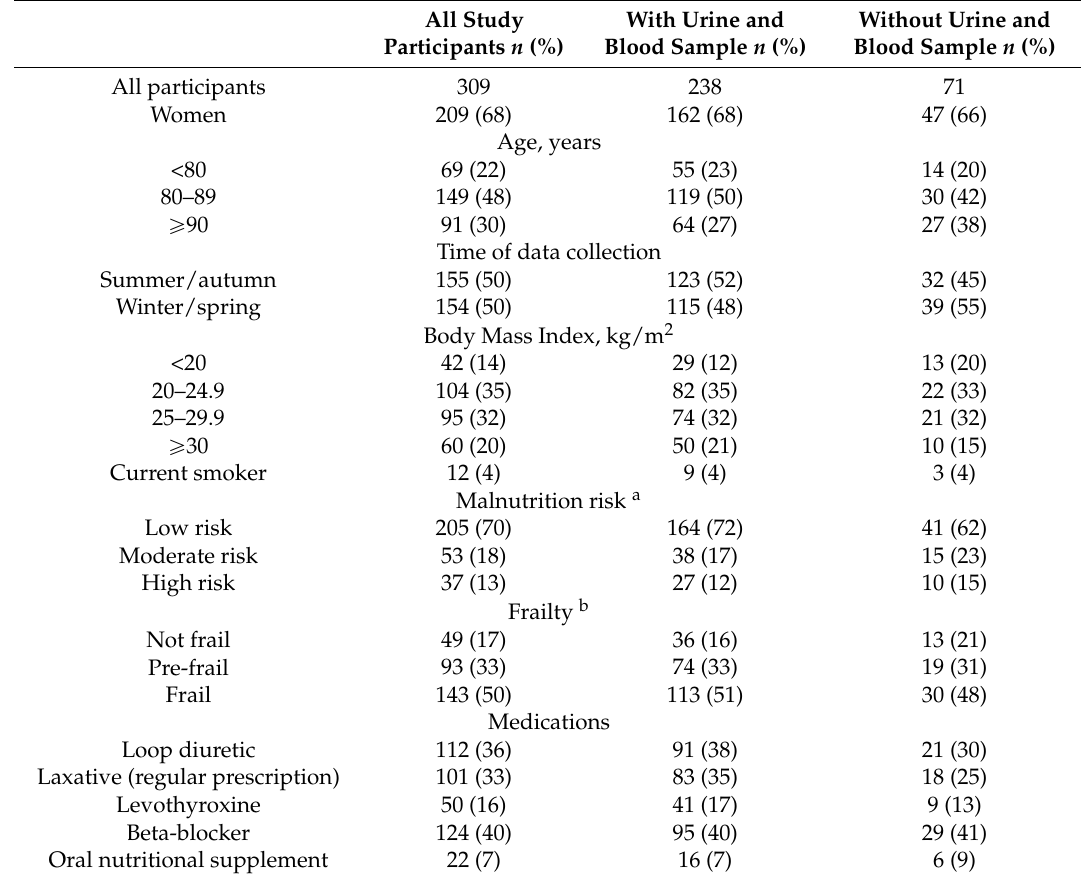
Table 1. Characteristics of study